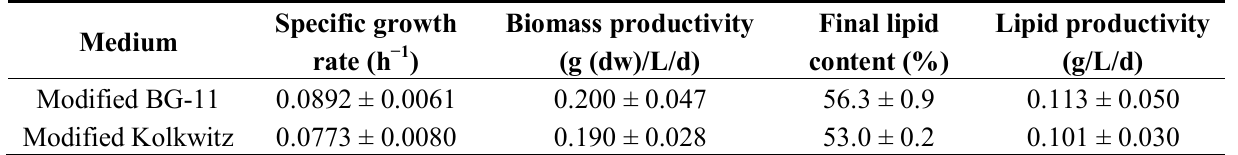
Table 4. Specific growth rate, biomass productivity, final lipid content and lipid productivity of Chlorella vulgaris CCALA 896 grown under N and P starvation